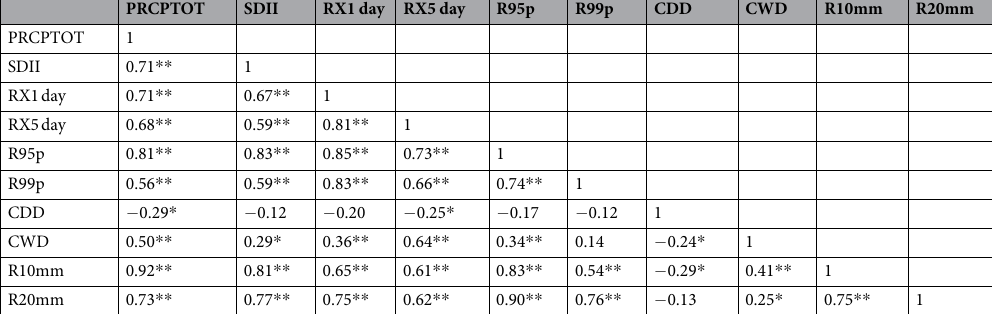
high mountains and about 85% of the annual precipitation falls in the growing season from May to September 39 .